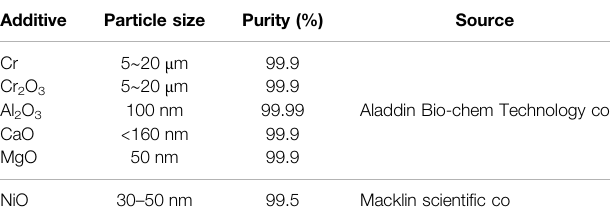
TABLE 1 | The basic information of the additive powders in this